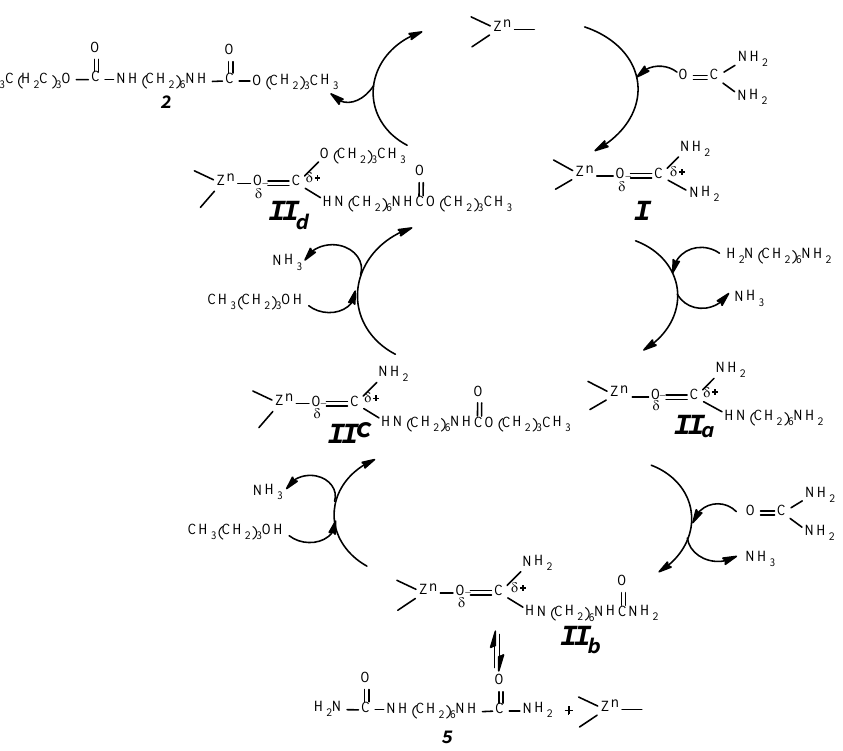
Scheme 1. Possible mechanism for the formation of 2 and 5 via one-pot reaction of HDA, urea, and butanol using ZnAlPO 4 as a catalyst. 2 : dibutyl hexane-1,6-dicarbamate; 5 : hexane-1,6-diurea.